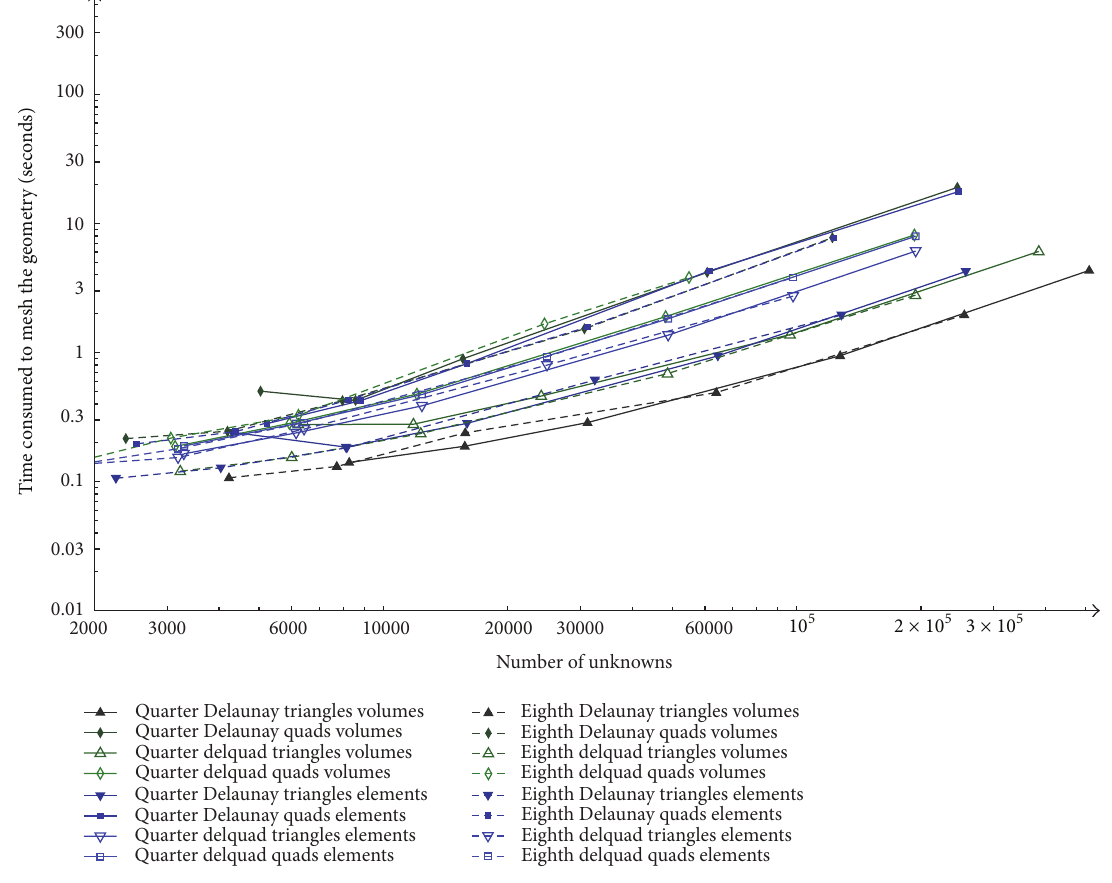
Figure 21: Time needed to mesh the geometry versus number of unknowns. Table 1: Macroscopic cross-sections (units are not stated in the original reference, but they are assumed to be in cm −1 or cm as appropriate). 𝐷 𝐷 1